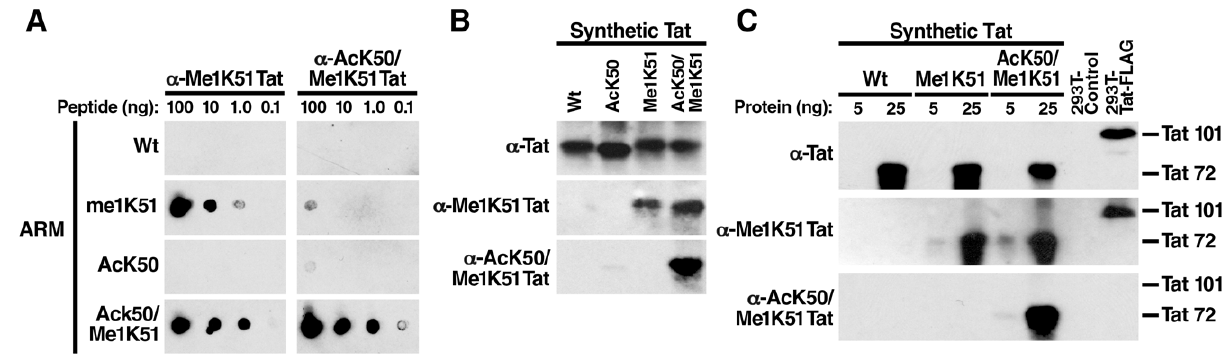
Figure 3. No detection of cellular acetylated/methylated Tat by newly generated Tat antibodies. (A) Dot-blot analysis of ARM peptides using a -Me1K51 or a -AcK50/Me1K51 Tat antibodies. (B) Western blot analysis of synthetic Tat (aa 1–72) with a -Tat, a -Me1K51 Tat or a -AcK50/Me1K51 Tat antibodies. Of note, we have not succeeded so far to synthesize a Tat peptide of 101 aa length corresponding to the full-length Tat species encoded by two tat exons in cells. (C) Whole cell lysates from 293T cell transfected with FLAG-tagged Tat (aa 1–101) were subjected to immunoprecipitation with a -FLAG agarose. Purified proteins were analyzed by western blot analysis together with synthetic Tat proteins using the indicated antibodies.